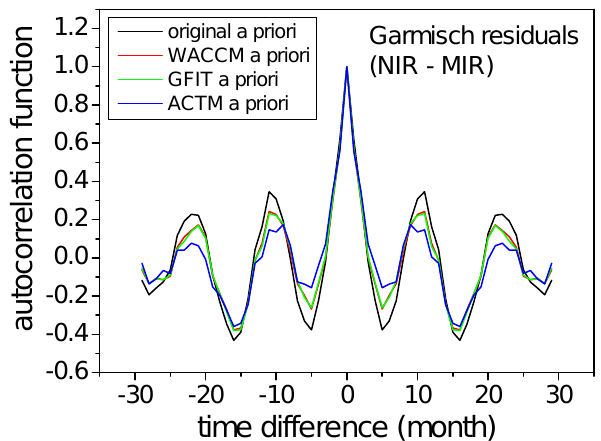
Fig. 7. Autocorrelation of Garmisch residuals, i.e. NIR–MIR differ- ence time series (see e.g., Fig. 5). Retrievals with original a priori profiles (black), and retrievals with WACCM (red), GFIT (green), and ACTM (blue) as common a priori